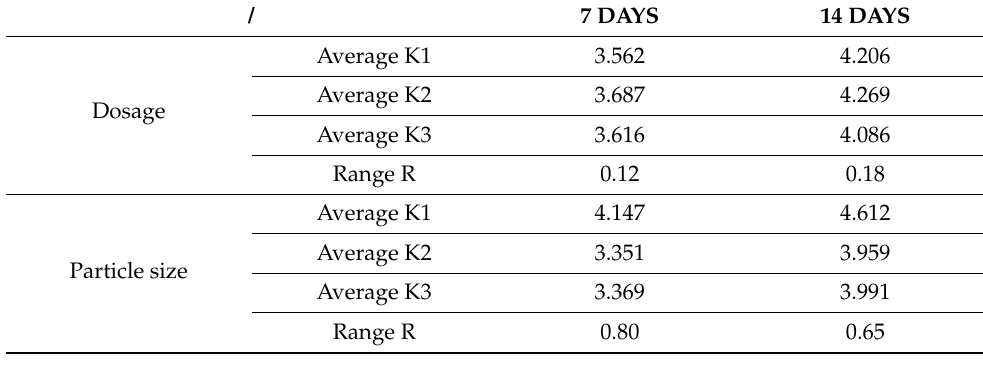
Table 5. Average and range of two variables’ influence on tensile strength.